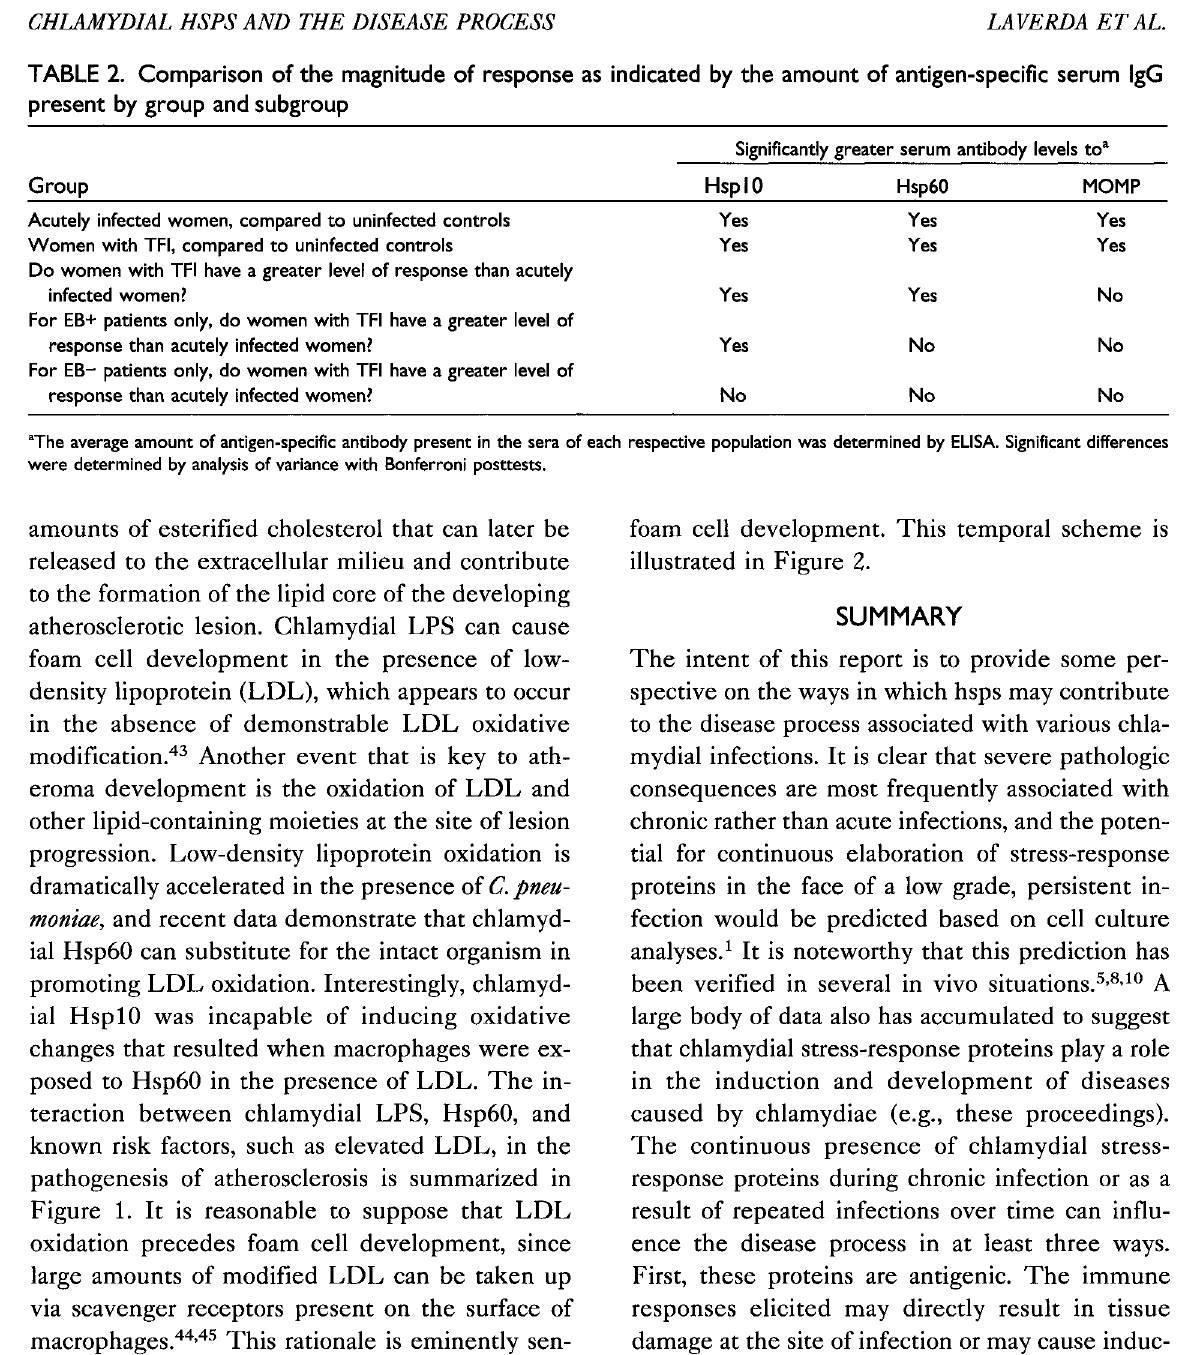
Significantly greater serum antibody levels to